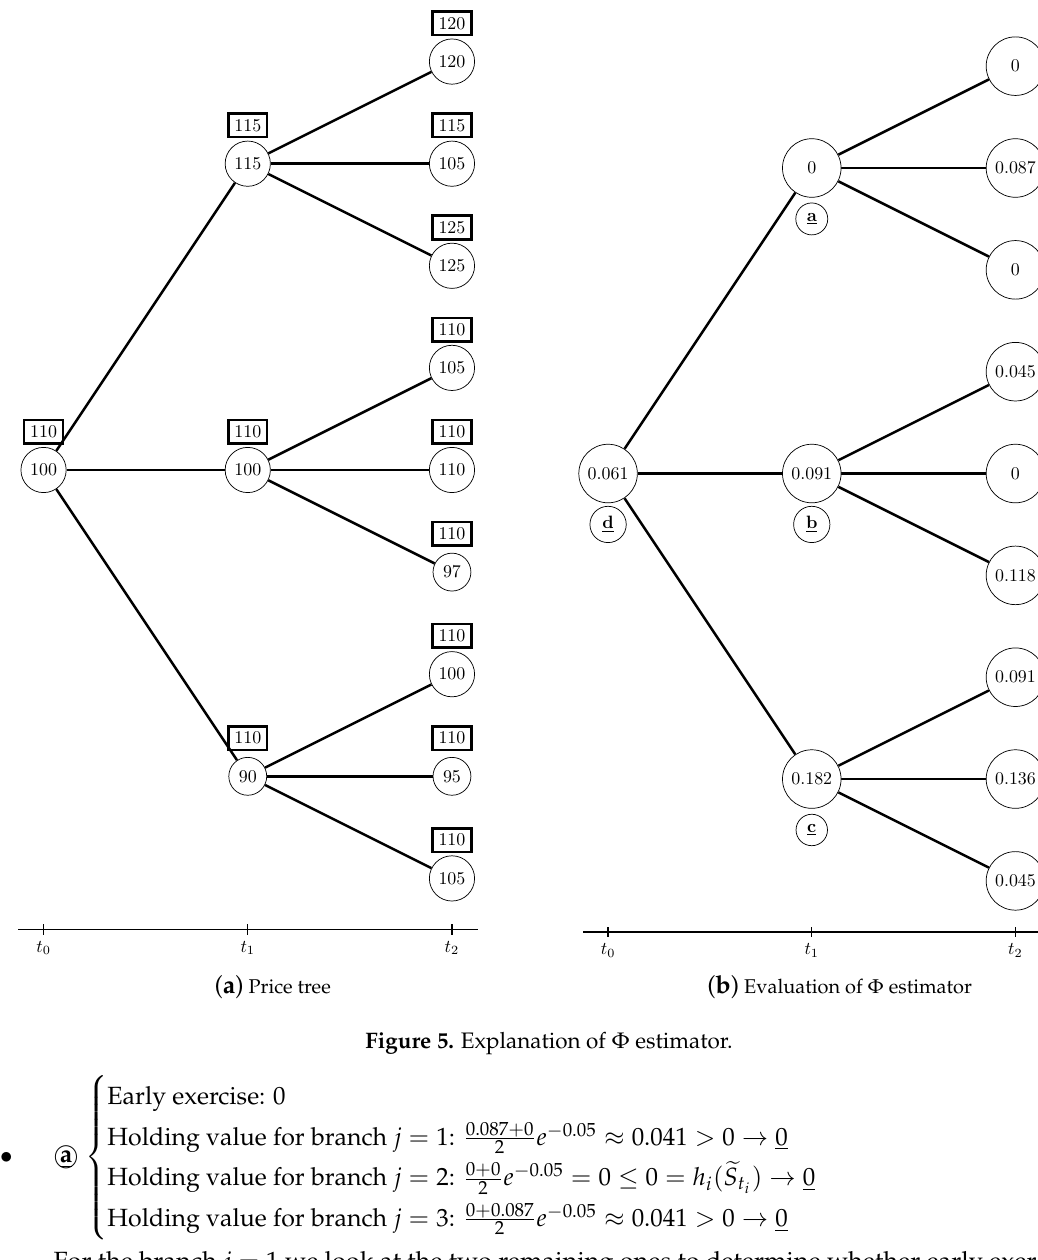
to Figure 5. Please note that in the following example, underlined numbers correspond to the final values associated with the specific branches of the tree.